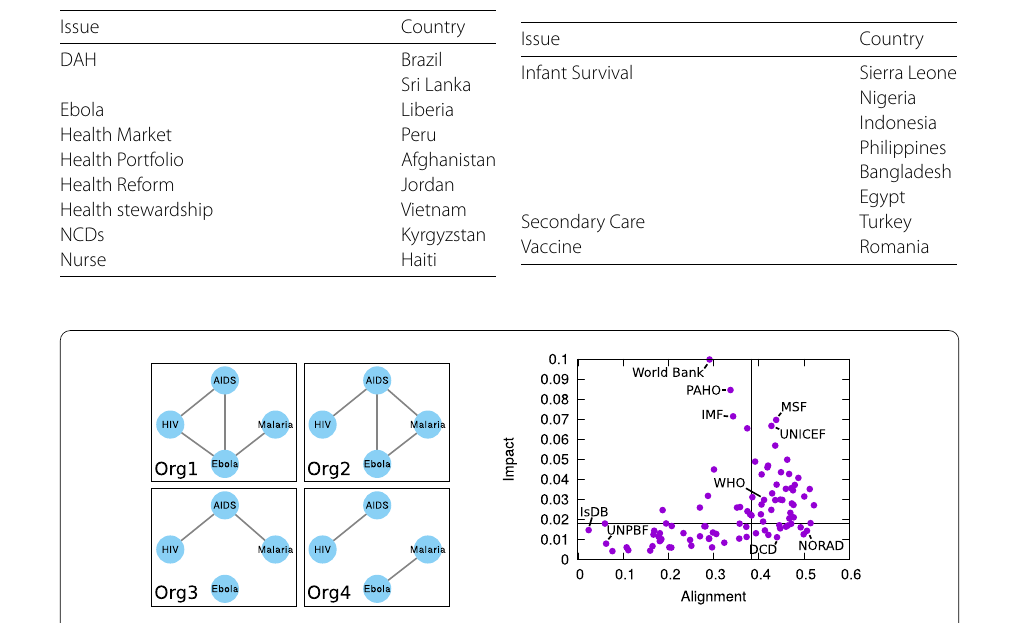
Figure 7 (Left) A toy example showing the fundamental structure of the multilayer network we analyze. ach quadrant is a different layer, containing the same nodes connected by different edges according to the data coming from the websites of different organizations. (Right) The relationship between the Alignment ( x -axis) and the Impact ( y -axis) of each organization in the multilayer network. The black lines show the median values of the two